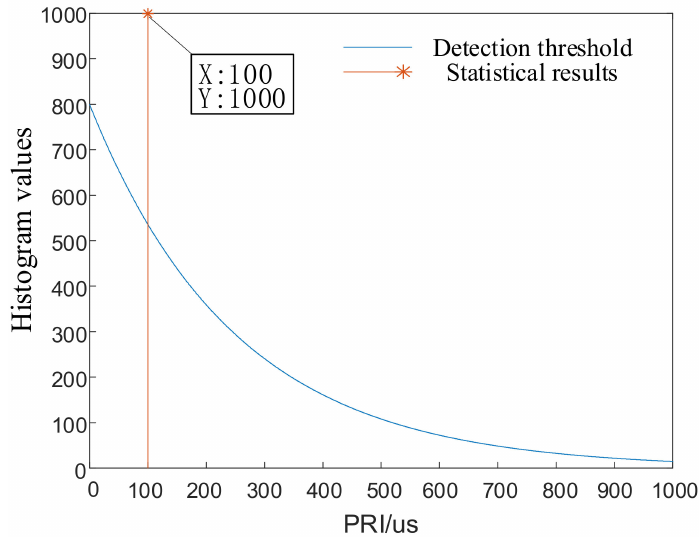
Figure 3. Histogram of the first-order TOA difference in simulation case